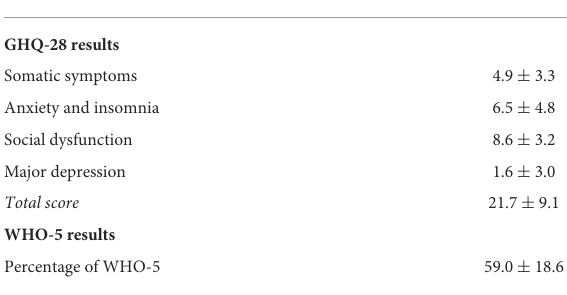
TABLE 2 PA habits and levels of physical therapists per week in pandemic time (IPAQ-SF).